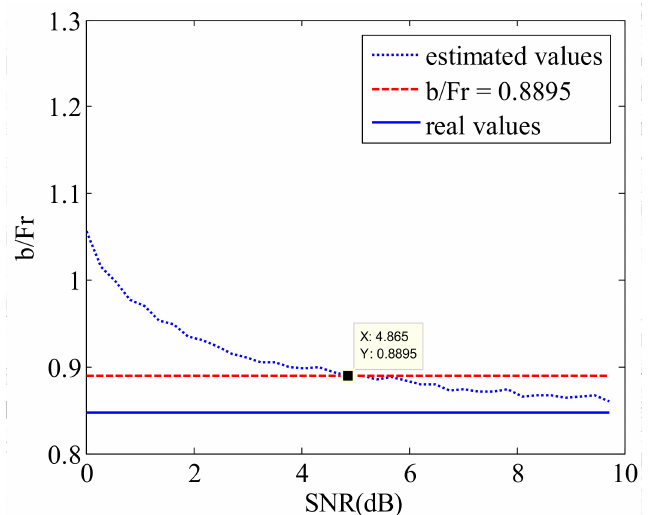
Figure 7. The comparison of estimated results and real values. The blue solid line is the real values of simulation data, the blue dotted line is the estimated values which is estimated by the proposed method, the red dashed line is the reference value ( b / F r = 0.8895) which is 5% larger than the real values. The values between red dashed line and blue solid line are considered to be more accurate results. SNR: signal-to-noise